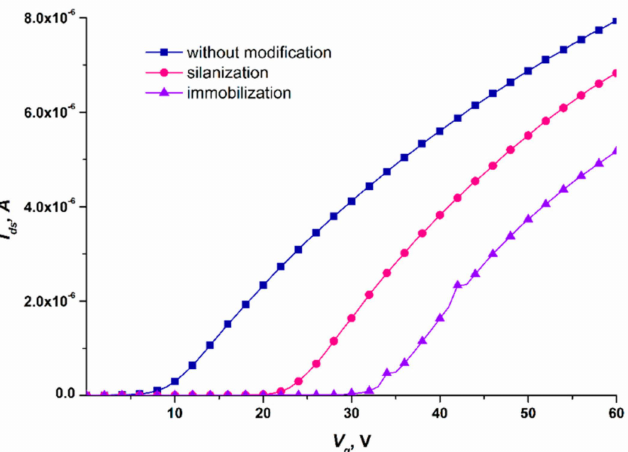
Figure 6. Typical volt–ampere characteristics recorded for one and the same nanowire on the SOI-NW chip with n-type conductivity. Measurement conditions: 1 mM PPMB; V g = 0 – 60 V, V ds = 0.2 V; the oDNA probe probe_1 was covalently immobilized on the nanowire. The VACs were recorded before the nanowire functionalization (blue curve), after the nanowire silanization (pink curve), and after its sensitization with oDNA probes (violet